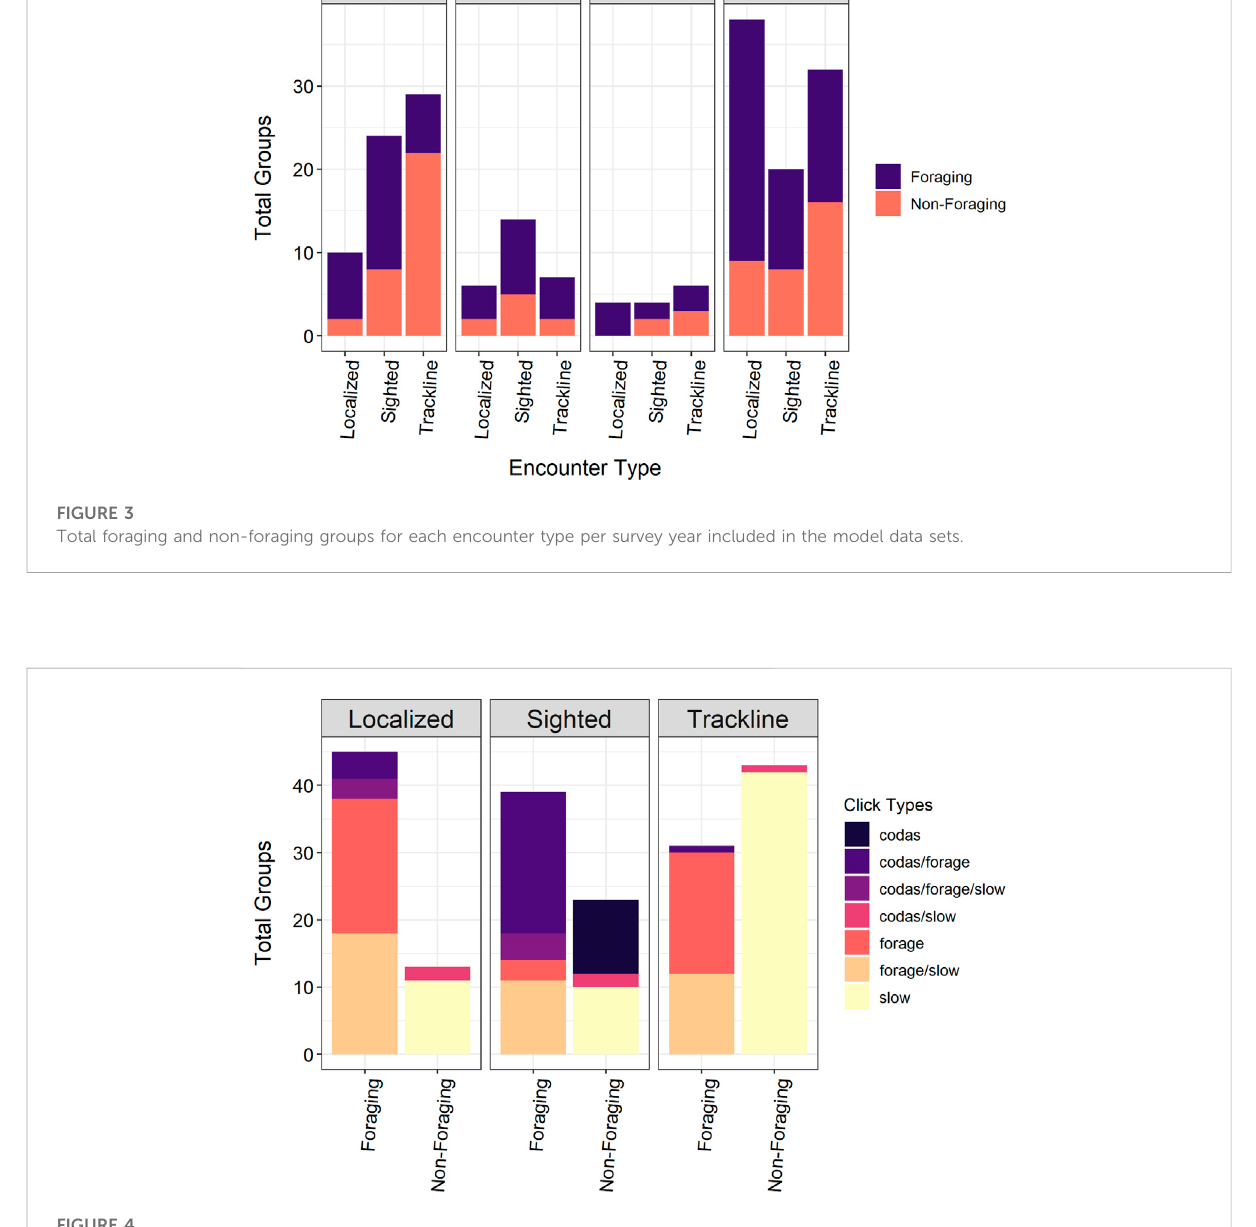
FIGURE 4 Different combinations of click types present in the foraging and non-foraging groups per encounter type (localized, sighted, trackline). “ Forage ” clicks include regular clicks and/or